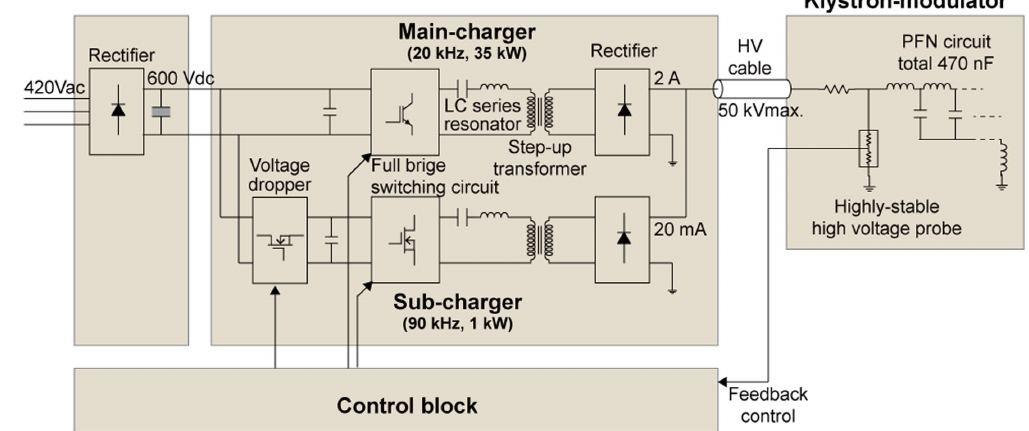
FIG. 12. Schematic of the high-voltage charger. It has two charging circuits: a main charger and a subcharger, connected in